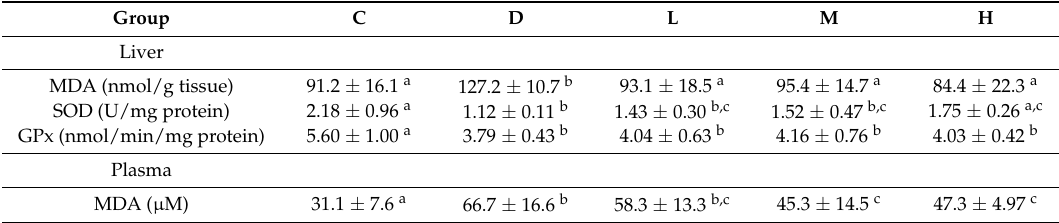
Table 6. Plasma and liver malondialdehyde (MDA), superoxide dismutase (SOD) and glutathione peroxidase (GPx) activity after the six-week melatonin